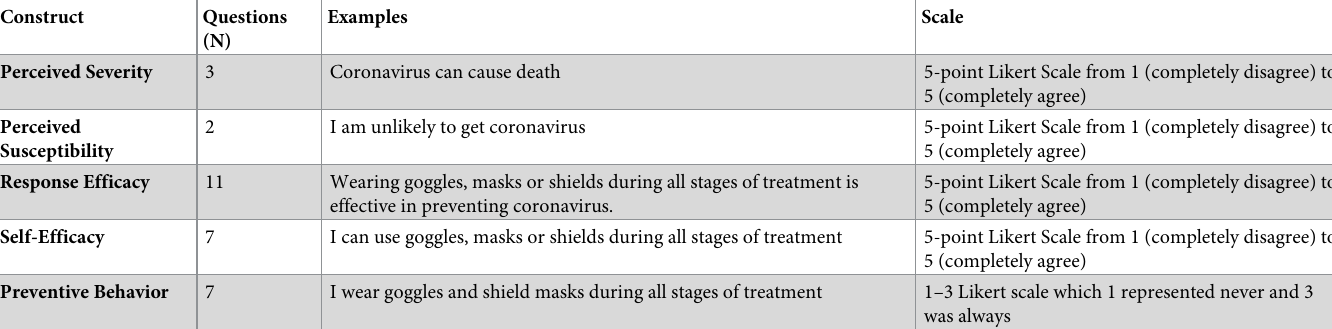
Table 1. EPPM questionnaire about health behaviors regarding COVID-19 epidemic in oral health care providers.